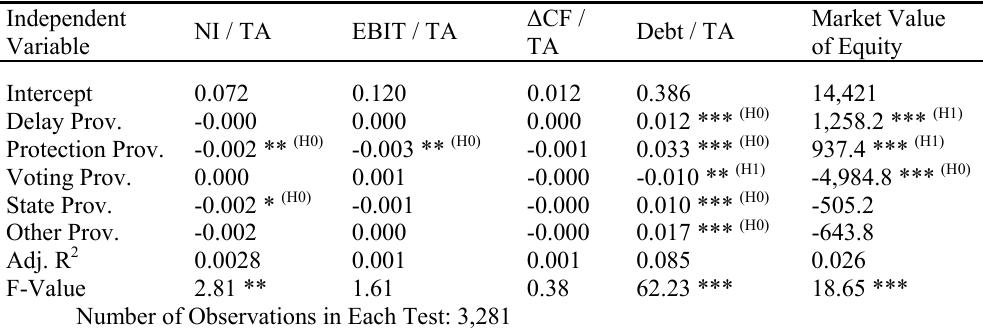
Table 5. Summary Results of the Accounting Ratios